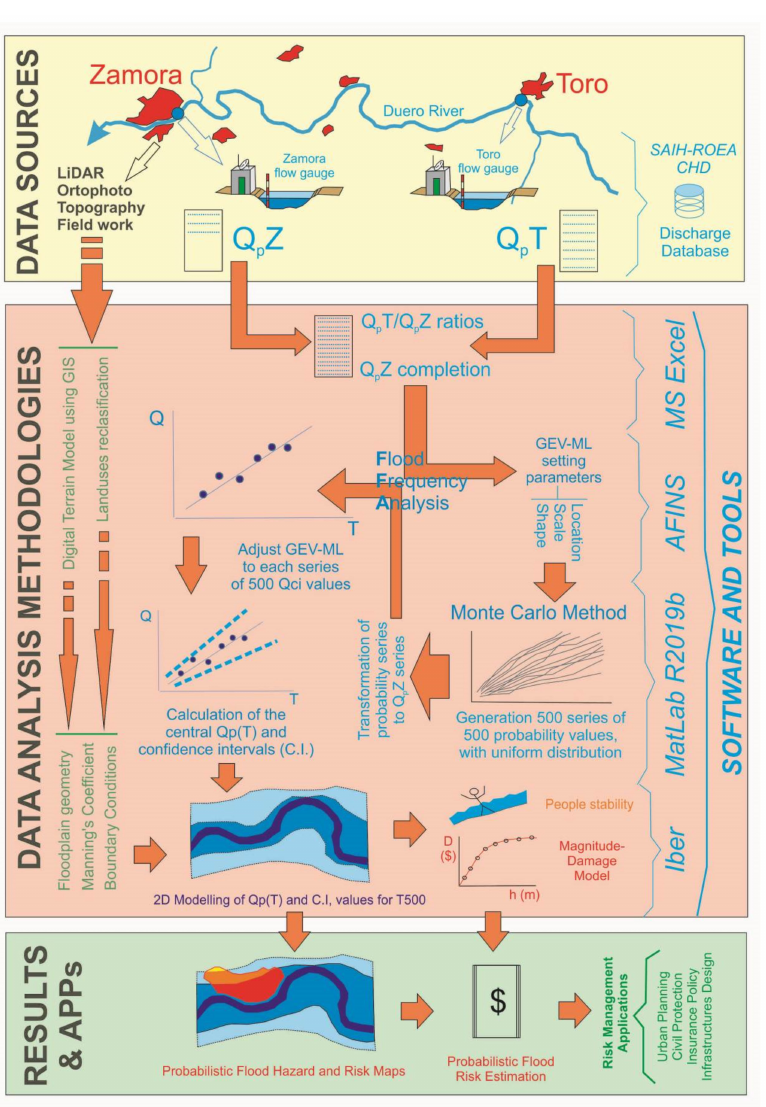
Figure 2. Flow chart of methodological approach for probabilistic flood hazard maps of Zamora city